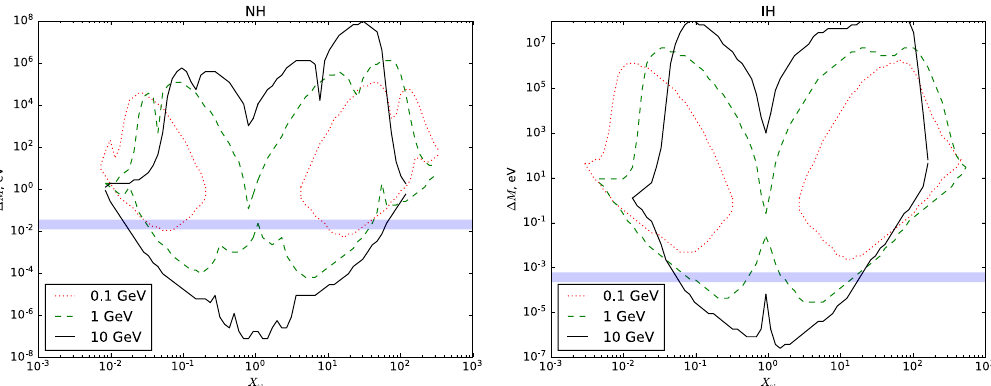
Figure 4 . Allowed region in the X ∆ M plane obtained for the fixed values of the phases (8.1). It ω − obs within the corresponding regions. Common masses of the HNLs is possible to generate Y B ≥ Y B are fixed to be equal to 0 . 1 , 1 . 0 , 10 GeV. The blue horizontal line indicates the zero-temperature Higgs contribution to the physical mass difference δM in the limit ∆ M/M